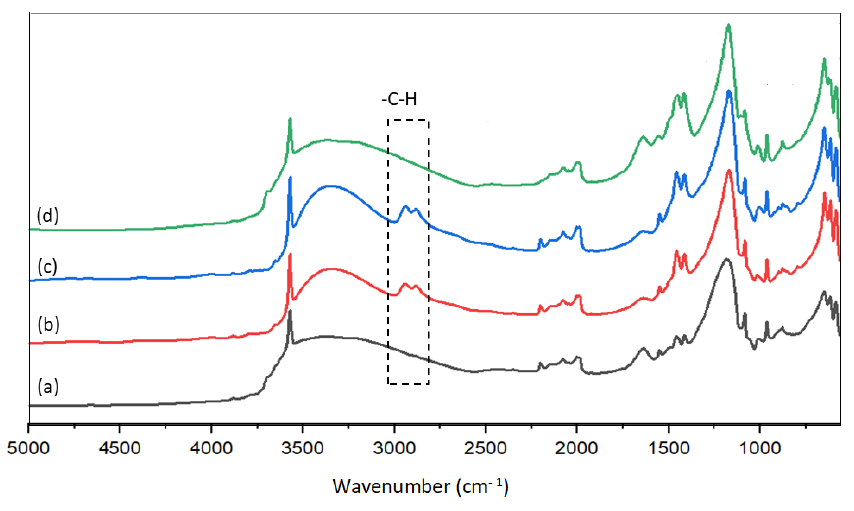
Figure 7. IR spectra for ( a ) HAp-S before the reaction and spent catalysts ( b ) HAp-Et-1, ( c ) HAp-W-1, and ( d ) HAp-Et-Cal-1.